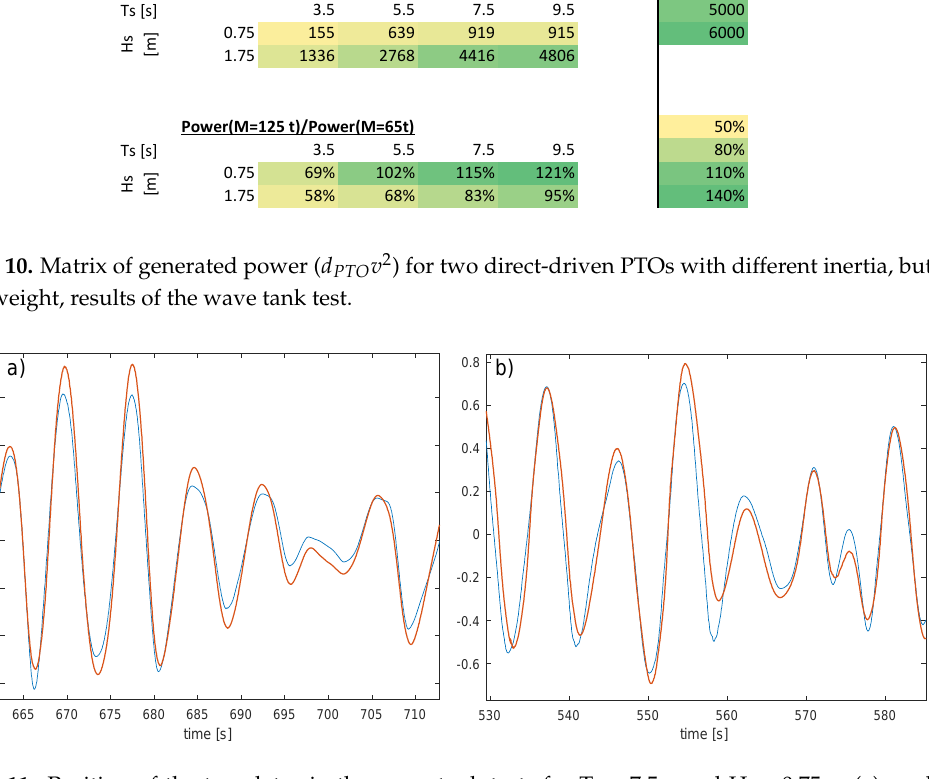
Figure 11. Position of the translator in the wave tank tests for Ts = 7.5 s and Hs = 0.75 m ( a ), and Hs = 1.75 m ( b ). The thin blue curve is from the PTO with low inertia (53 t), the thick orange curve with high inertia (101 t). The damping was set to 100 kNs/m. All values scaled to full scale equivalents.